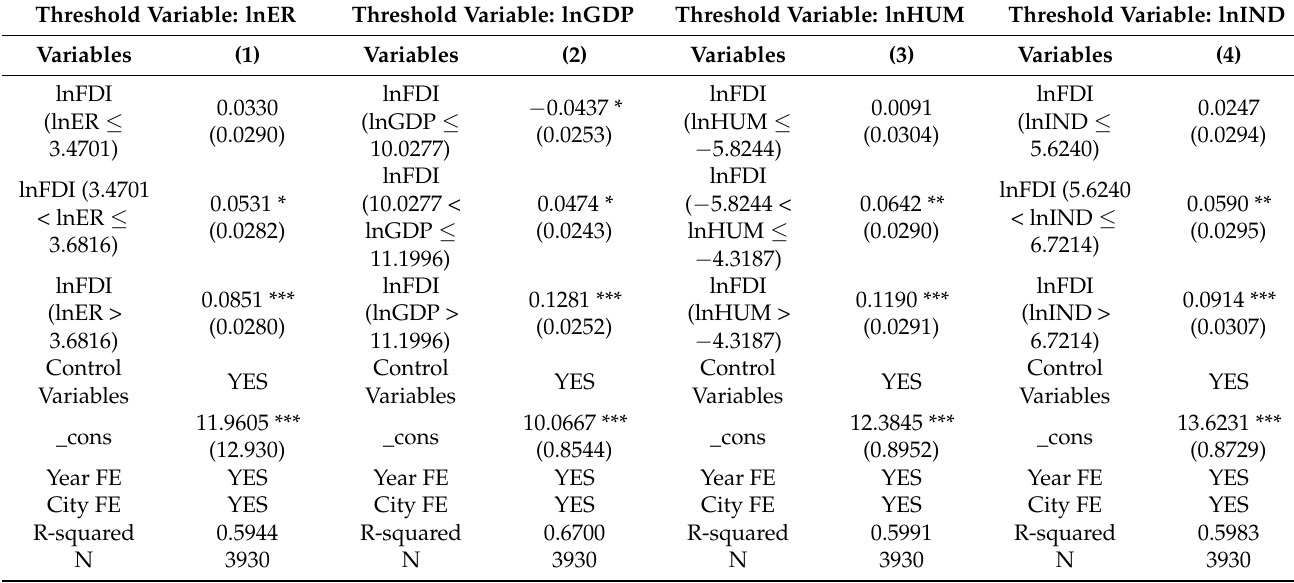
Table 7. Robustness test adding additional external